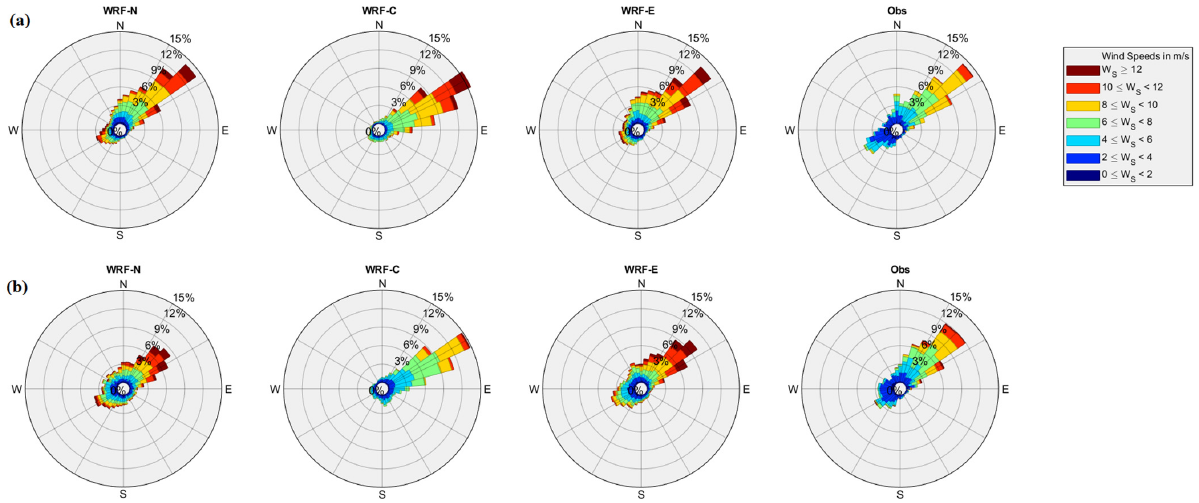
Figure 7. Wind rose diagram on an hourly timescale from the models and observations for the years ( a ) 2015 and ( b ) 2016 in Dongsha Island.